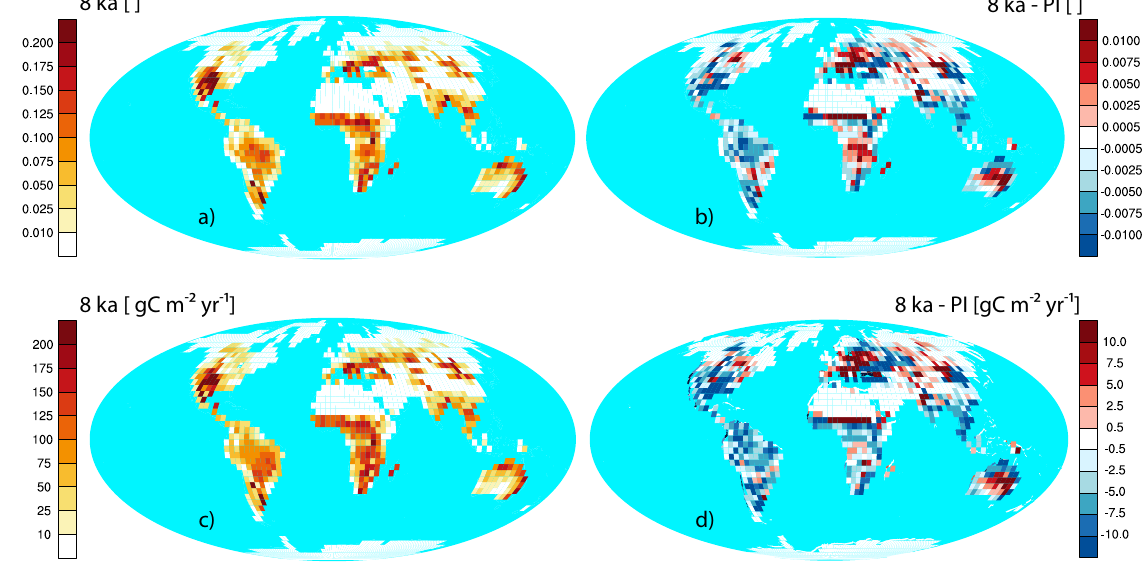
Fig. 1. Yearly burned fraction of grid cell area [m 2 m − 2 ] of natural fire activity (a) and carbon emissions [gCm − 2 yr − 1 ] (c) for the mid- Holocene (8ka=8000calyrBP) and their anomalies (b, d) to burned fraction with pre-industrial (PI=200calyrBP)